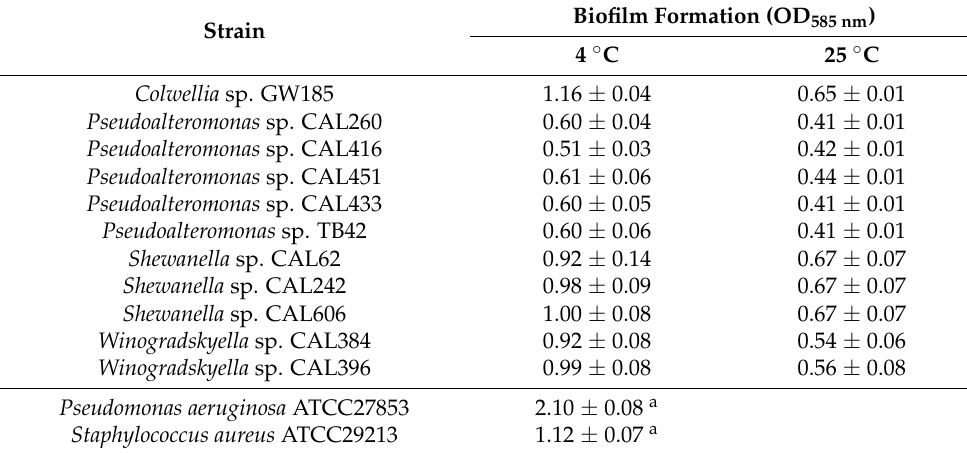
Table 2. Biofilm formation by Antarctic sponges-associated bacterial strains incubated at 4 ◦ C for 96 h, or at 25 ◦ C for 48 h, and P. aeruginosa and S. aureus after incubation at 37 ◦ C for 48 h and 24 h, respectively. Each value was obtained by four independent experiments performed in triplicate. Standard deviations are reported ( a : incubation temperature 37 ◦